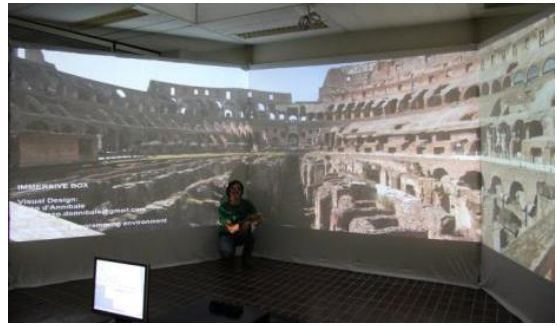
Figure 18. VR system for virtual navigation immersive